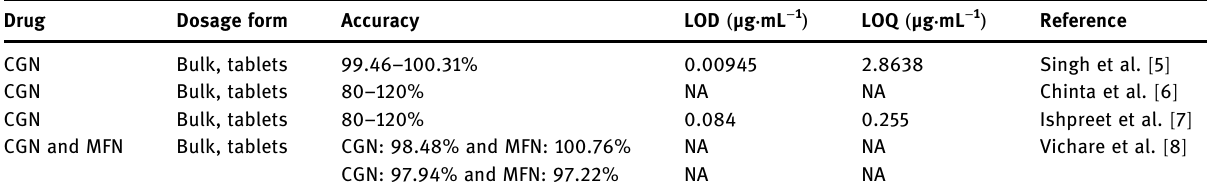
Table 1: Overview of published UV - Vis spectroscopic methods